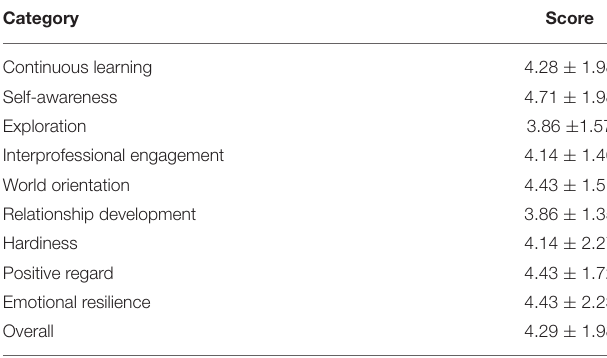
TABLE 5 | Summary of Intercultural Effectiveness Scale survey